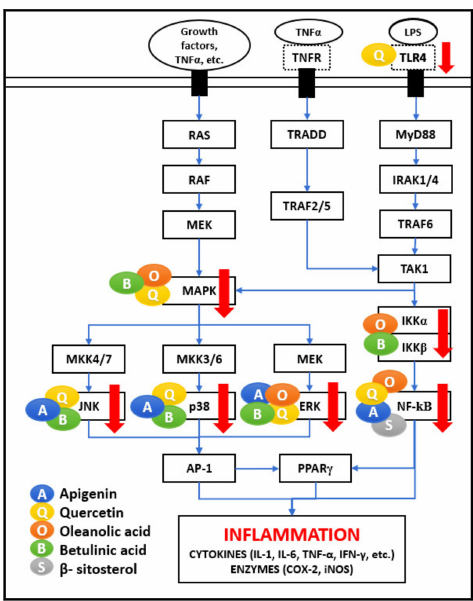
Figure 2. NF- κ B and MAPK network. The five bioactive compounds detailed in this review show a range of immunomodulatory activities on these two pathways. The major effect of these compounds is seen for MAPK, JNK, p38, ERK, and NF- κ B. The bioactive compounds are shown as coloured circles and are indicated alongside their respective molecular targets (Blue: Apigenin, Yellow: Quercetin, Orange: Oleanolic acid, Green: Betulinic acid, Grey: β -Sitosterol). The bold red arrows indicate the downregulation of respective pathways. The entities of bold square boxes represent different signaling molecules/complexes. The entities of dotted square boxes represent different receptors for signaling pathways. The entities of circle boxes represent the inducers/activators of the particular pathways. → represents direct